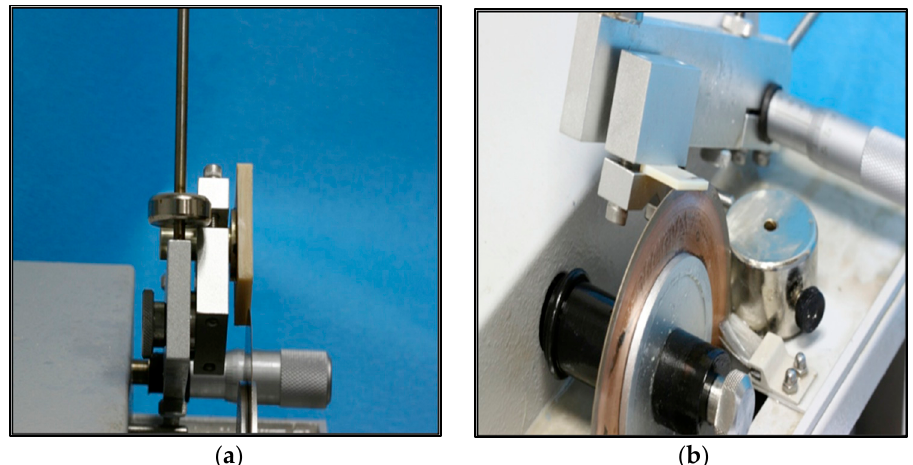
Figure 3. ( a ) Isomet low-speed parallel cut. ( b ) Isomet low-speed perpendicular cut.